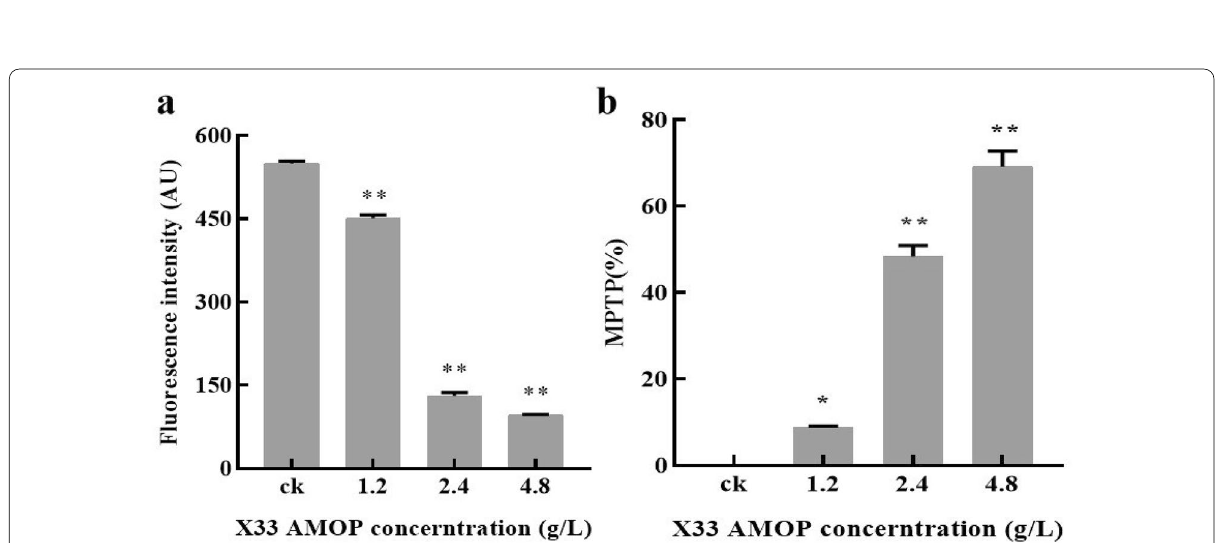
Fig. 6 Effects of X33 AMOP treatment on mitochondrion damage of P. digitatum . a Effect of X33 AMOP on MMP of P. digitatum . b Effect of X33 AMOP on MPTP of P. digitatum . The data were shown as the mean